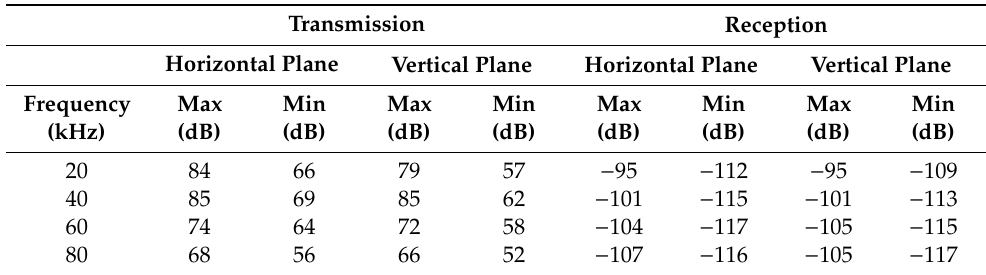
Table 1. Maximum and minimum of dB values obtained from the directivity measurements for the Archimedean spiral-like transducer.